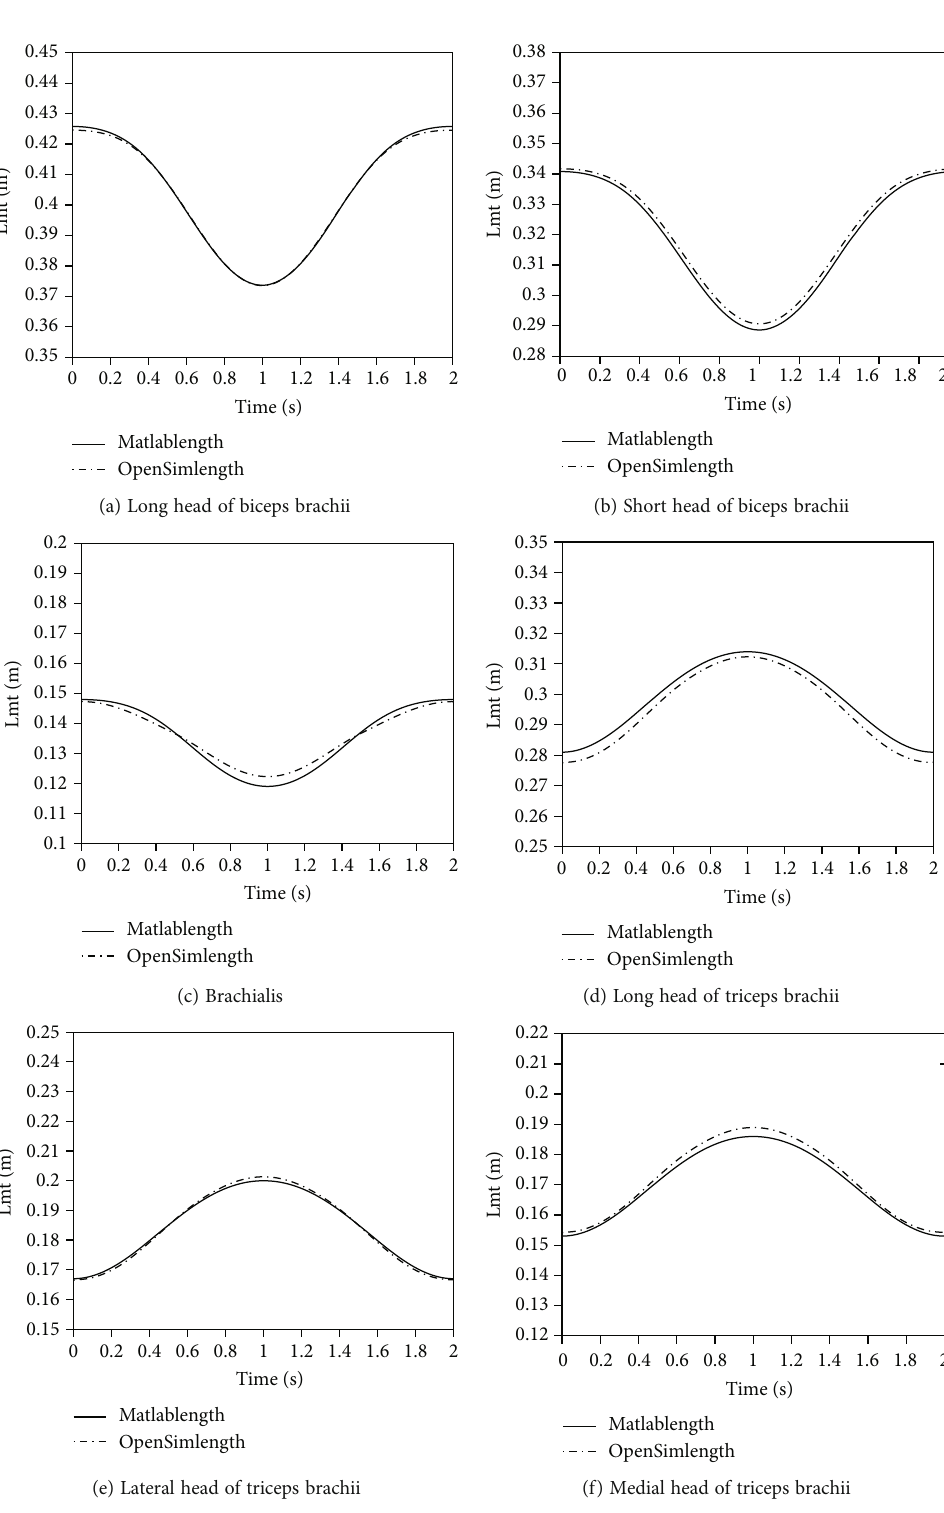
Figure 10: Muscle length and time relationship under two